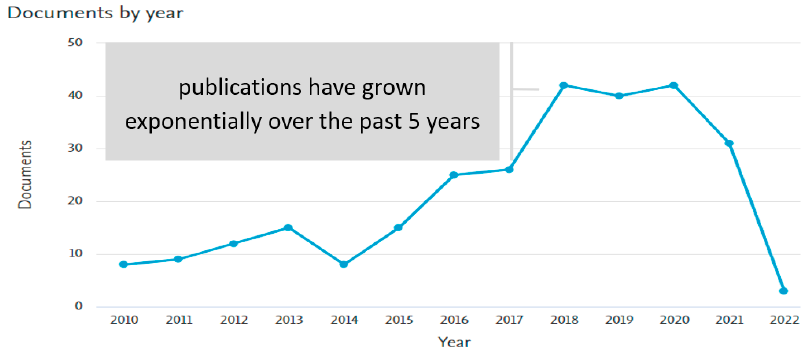
Figure 2. Agile AND transformation AND manufacturing—Documents by year.